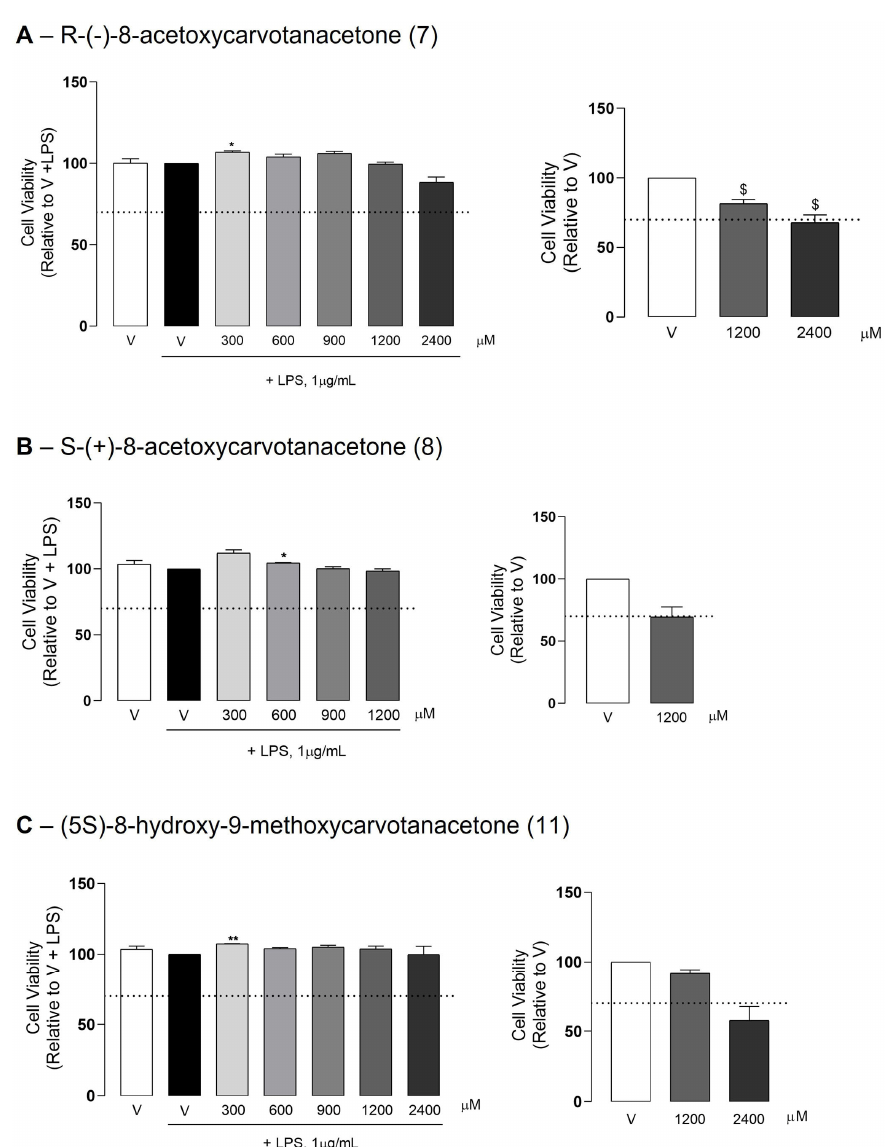
Figure 1. Effect of the test compounds on cell viability. Raw 264.7 macrophage cultures were treated with the selected concentrations of the test compounds or the vehicle (0.1% DMSO) for 1 h followed by the addition of LPS and further incubation for 18 h, or treated with 1200 or 2400 µ M of each test compound or the vehicle alone (0.1% DMSO) also for 18 h. Each column represents the mean ± SEM of three independent experiments. * p < 0.05 and ** p < 0.01 relative to LPS-treated cells. $ p < 0.05 relative to the vehicle alone (V). The dotted line represents the 70% cell viability mark that is accepted according to ISO 10993 ‐ 5, as the lower limit for the absence of cytotoxicity.